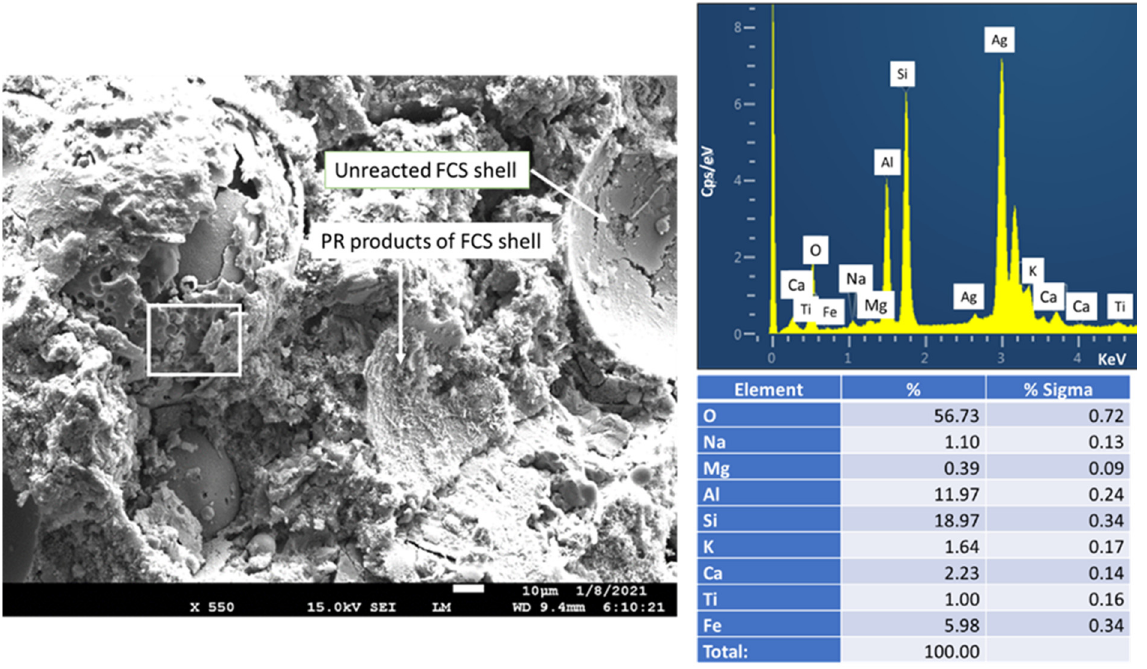
Figure 26. SEM image and EDX elemental composition of CAC blend with 3% PMHS-treated FCS after autoclaving for 24 h at 250 °C.